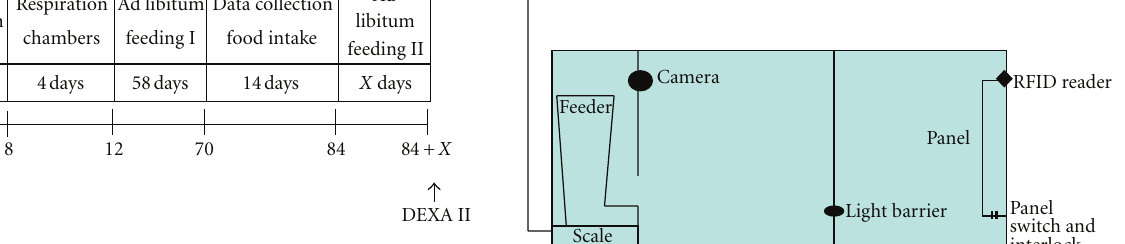
Figure 1: Experimental study design of the five experimental phases including measurements in the respiration chambers, measure- ments of food intake as well as dual energy X-ray absorptiometry measurements. Table 1: Chemical composition (%) of the commercial dry cat food used during the whole experiment.